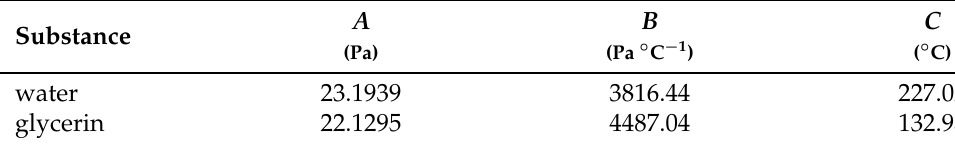
Table 2. Coefficients for Antoine Equation (1) reported by Soujanya et al. [17].